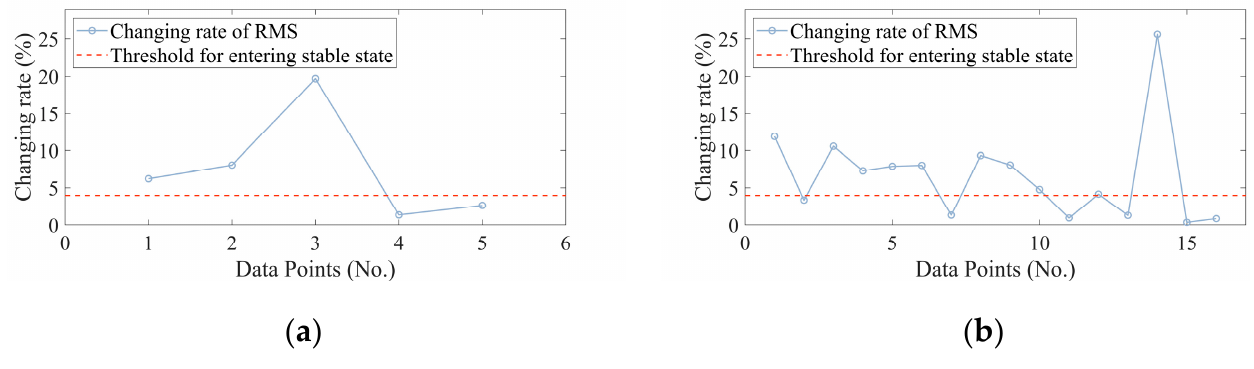
Figure 14. Waterfall plots of sub-band features and corresponding MCHs for signals: ( a ) sub-band features of Dataset 1, ( b ) MCHs of Dataset 1, ( c ) sub-band features of Dataset 2, ( d ) MCHs of Dataset 2.